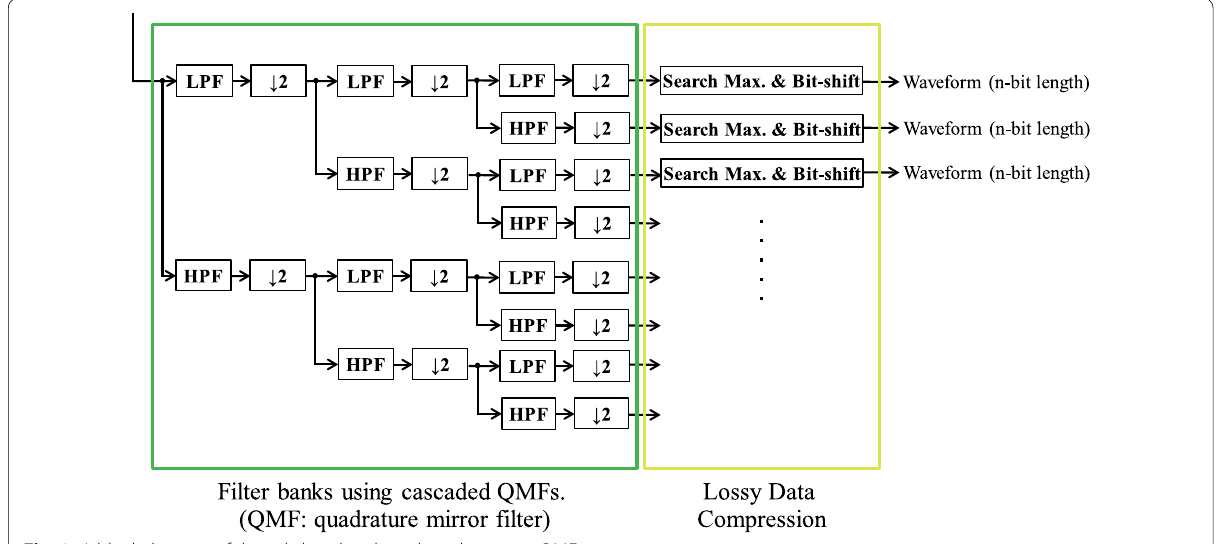
Fig. 8 A block diagram of the sub-band coding algorithm using QMF